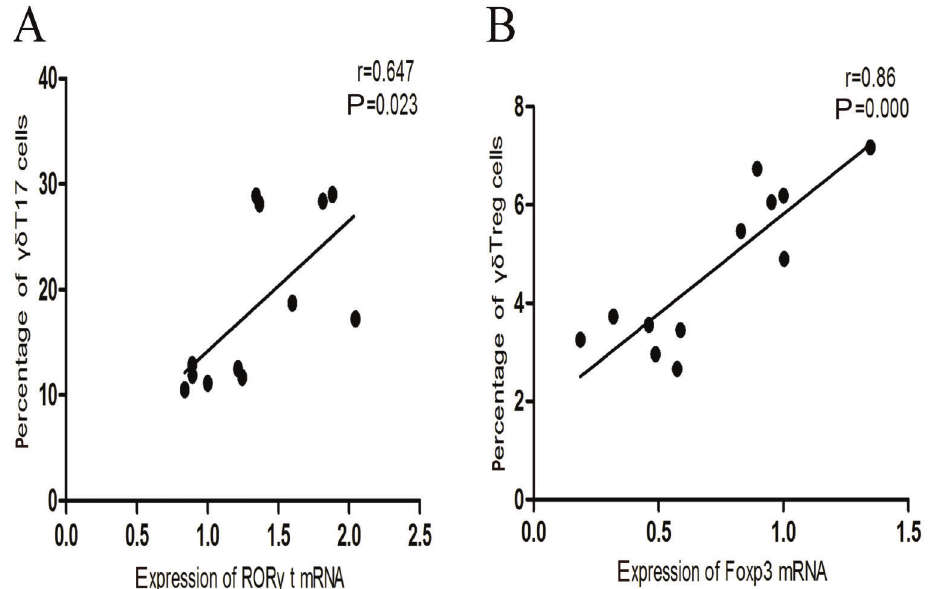
Figure 9. Correlation between ( A ) mRNA of ROR g t and the percentage of gd T17 cells (r=0.647, P o 0.05), as well as between Foxp3 and the percentage of gd Treg cells (r=0.86, P o 0.05) in the asthmatic model group ( B